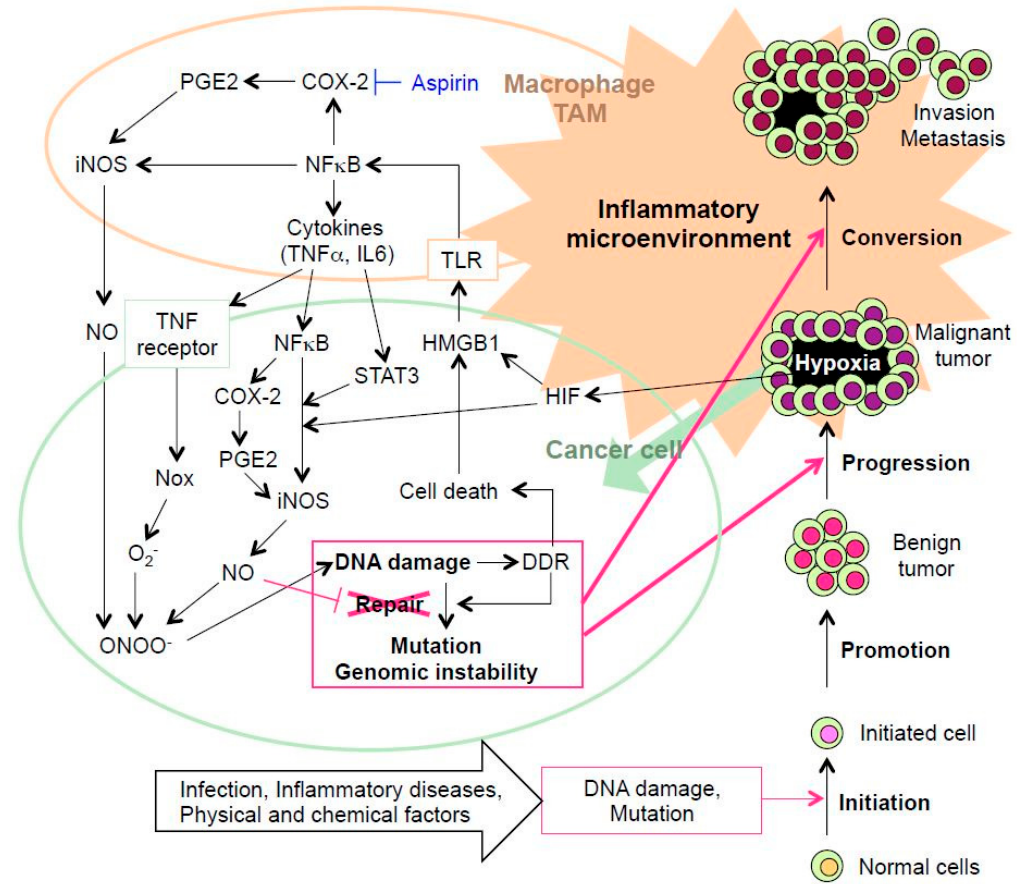
Figure 2. Mechanism for crosstalk between DNA damage and inflammation in the multiple steps of carcinogenesis. In cancer cells, cell death, which is induced by ROS and RNS, can induce HMGB1 expression. HMGB1 is passively released into the extracellular space from damaged or necrotic cells. Hypoxia induces HIF-1 expression, which regulates iNOS expression, and promotes translocation of HMGB1 from the nucleus to the cytoplasm. Via TLR4, extracellular HMGB1 can promote NF- κ B transportation to the nucleus and induce the expression of TNF- α and IL-6, which induce iNOS expression. NO, which is generated by iNOS in tumor-associated macrophage (TAM), is released to the extracellular space and interacts with O 2 − generated via Nox in cancer cells to form ONOO − . ONOO − causes DNA damage resulting in mutations and genomic instability as not properly repaired. NF- κ B induces not only iNOS but also COX-2 expression. COX-2 participates in formation of PGE2, which induces iNOS. Aspirin can inhibit COX-2, resulting in the decrease of PGE2 and iNOS and suppression of the crosstalk between DNA damage and inflammation in cancer development. This is a possible mechanism by which aspirin reduces the long-term risk of death due to cancer.